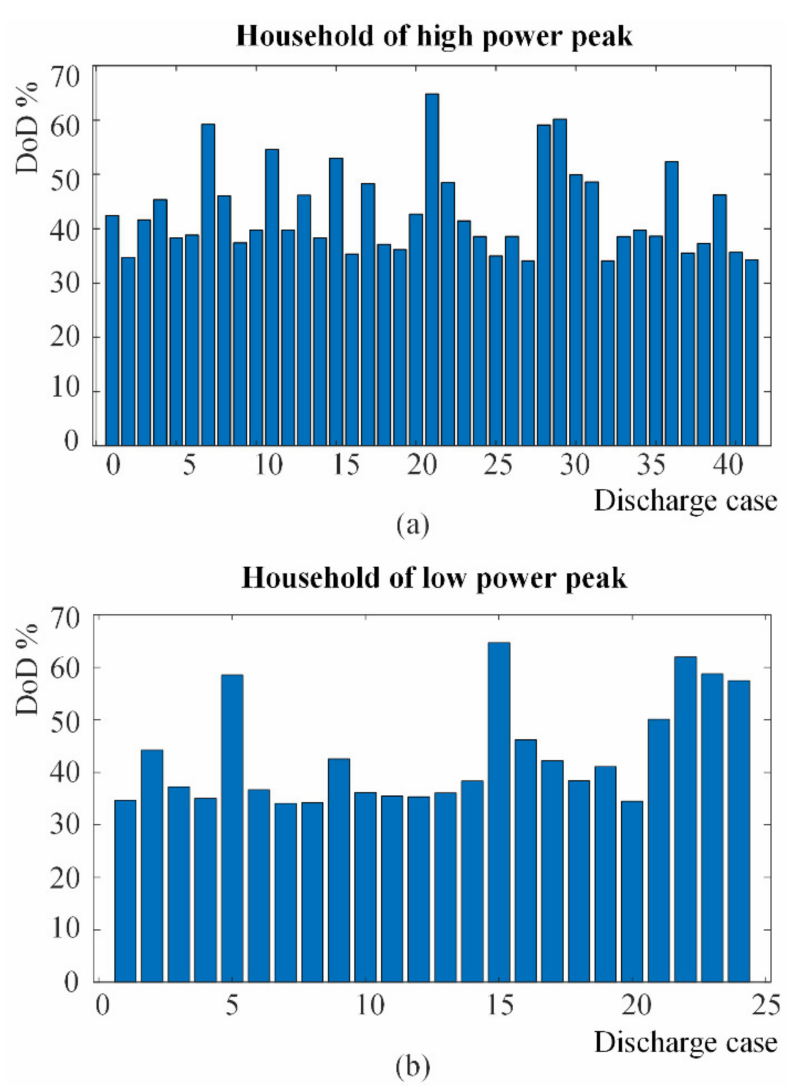
Figure 20. Maximum DoD in each discharge cycle in case of ( a ) high power peak and ( b ) low power